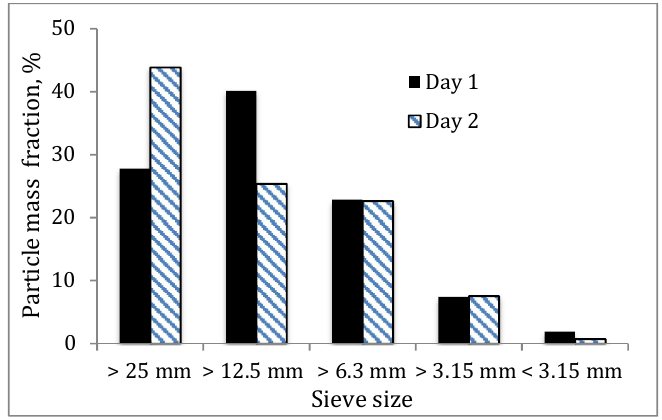
Figure 4. Mass fraction of the biomass particles and their size distribution for each day of the test conducted at the tissue plant.